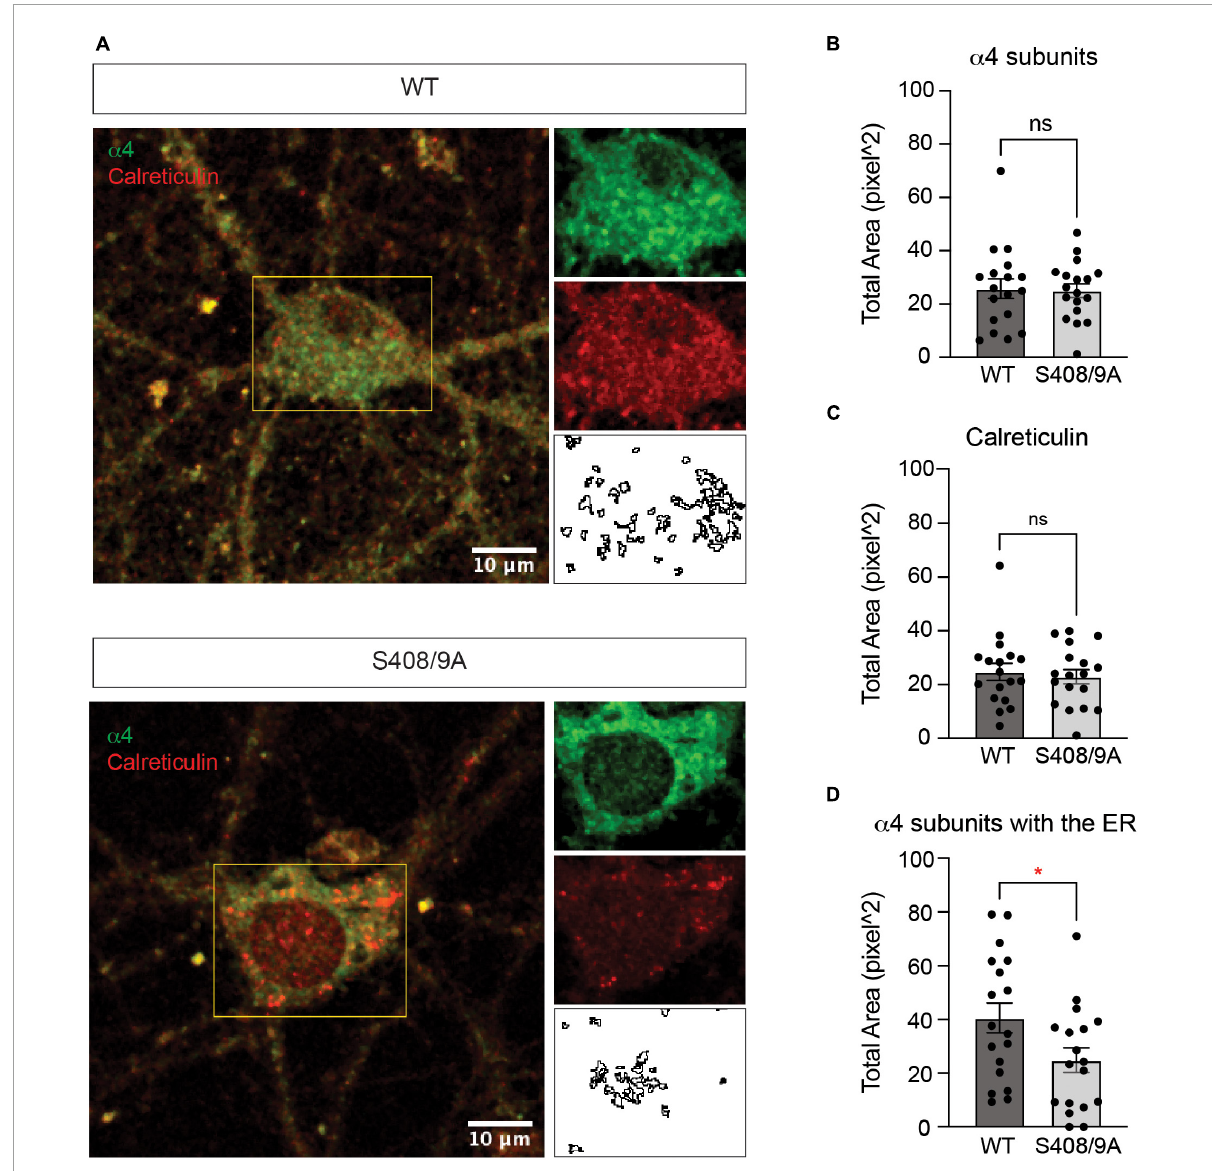
FIGURE9 Colocalization of the α 4 subunit with calreticulin is reduced in cultured neurons from S408/9A mice. (A) Representative images of the soma of DIV21 neurons cultured from WT and S408/9A mice stained with the α 4 subunit and calreticulin antibodies are shown. Individual channels and areas of colocalization for each cell are shown on the right. (B) Total area of the α 4 subunit staining in the soma is not affected by the S408/9A mutation (ns ≥ 0.05, n = 18 cells from three individually prepared cultures). (C) There is no significant difference in calreticulin staining in the soma between WT and S408/9A cultures (ns ≥ 0.05, n = 18 cells from three individually prepared cultures). (D) Colocalized area of the α 4 subunit with calreticulin is reduced in S408/9A cultures when compared to WT cultures (* p ≤ 0.05, n = 18 cells from three individually prepared